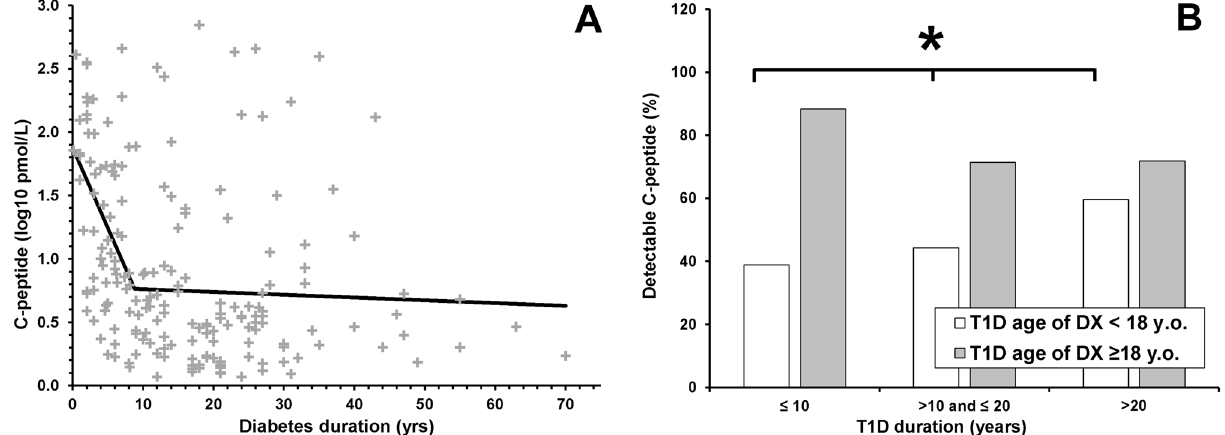
Figure 1. ( A ) Segmental linear regression of detectable C-peptide levels versus Type 1 diabetes duration. Overall r = 0.45, slope before threshold p = 0.0005, slope after threshold p = 0.66; diabetes duration threshold 8.8 (95% CI 5.7, 11.9) years ( p < 0.0001). ( B ) Comparison of proportion of detectable C-peptide in participants with diabetes stratified by age of diabetes diagnosis and duration. Significant positive trend in percentage of detectable C-peptide with diabetes duration in diabetes diagnosed below 18 y.o. ( p = 0.01) and borderline negative trend in diabetes diagnosed ≥ 18 y.o. ( p = Different detectable C‑peptide rates and levels by age of diabetes onset and duration. Plasma C-peptide was detectable in 46.3% (114 of 246) and 79.2% (76 of 96) of participants with diabetes aged < 18 y.o. and ≥ 18 y.o. at diabetes diagnosis respectively, p < 0.0001. In those with detectable C-peptide, the median C-peptide levels were lower in participants with diabetes with earlier (< 18 y.o.) versus later onset (≥ 18 y.o.) dia- betes: 4.2 (2.6–12.2) pmol/L versus 8.0 (2.3–80.5) pmol/L, p = 0.02. C-peptide was detectable in 53.8%, 50% and 62.2% participants with diabetes duration ≤ 10 years, 10–20 years and > 20 years respectively (trend p = 0.22). In people with childhood-onset diabetes C-peptide was more often detectable in those with longer versus shorter diabetes duration (60% vs. 39%, p for positive trend < 0.05). In those with diabetes diagnosed at age ≥ 18y.o there was a non-significant negative trend for the percentage of people with detectable C-peptide and diabetes dura- tion (from 88 to 72%, p = 0.07) (Fig. 1B). For those with detectable C-peptide, C-peptide levels did not differ significantly by diabetes duration. There was no difference in detectable C-peptide rates with diabetes duration in participants diagnosed below and above 13 years of age, a common age of diabetes onset and puberty 15 (ESM Fig. 1). There were no significant differences between C-peptide detectability or levels by diabetes complications status (data not shown). C‑peptide micro‑secretion is associated with lower HbA1c. There were no significant differences in concurrent HbA1c levels by diabetes duration if C-peptide status was not considered. However, participants with diabetes, with detectable versus undetectable C-peptide, had lower concurrent HbA1c levels: 8.2 ± 1.7% (66 ± 18 mmol/mol) versus 8.5 ± 1.4% (70 ± 16 mmol/mol), p = 0.001. In those with earlier diabetes onset (< 18 y.o.) HbA1c was lower with detectable versus undetectable C-peptide: 8.4 ± 1.8% (68 ± 19 mmol/mol) versus 8.6 ± 1.5% (70 ± 16 mmol/mol) respectively, p = 0.045. Similar results were observed in participants with adult- onset diabetes and detectable versus undetectable C-peptide: (7.7 ± 1.3% (61 ± 15 mmol/mol) versus 8.2 ± 1.1% (66 ± 12 mmol/mol) respectively, p = 0.053. Overall HbA1c levels were significantly lower in participants diagnosed at adult versus childhood age with- out considering C-peptide detectability status: 7.8 ± 1.3% (62 ± 14 mmol/mol) versus 8.5 ± 1.6% (69 ± 18 mmol/ mol), p = 0.001. HbA1c was lower in participants with detectable versus undetectable C-peptide in most diabetes duration categories, but reached statistical significance only in participants with 10–20 years diabetes: 7.9 ± 1.3% (64 ± 14 mmol/mol) versus 8.8 ± 1.4% (73 ± 16 mmol/mol), p = 0.003. Detectable C-peptide was not a significant predictor ( p = 0.06) of concurrent HbA1c reaching recommended targets (< 7% (53 mmol/mol) for adults, < 7.5% (58 mmol/mol) for youth) in models containing age, sex and age of T1D diagnosis (Table 2). Participants with detectable C-peptide had 97% (95%CI 23%, 217%; p = 0.005) higher odds of having a HbA1c level < 8% (64 mmol/mol) than those with non-detectable C-peptide in logistic regression (after adjustment for age, sex and age at diabetes onset) (Table 2). miRs profiles in participants with and without diabetes. The microRNA substudy included 305 participants with diabetes and 211 CON. Clinical characteristics are shown in Table 3. Expression of five miRs differed by diabetes status. miR-186 and miR-223 expression were significantly increased while miR-9, miR-22 and miR-125b were significantly decreased in people with diabetes versus CON (ESM Fig. 2 Panel A). Plasma miRs profiles by age of diabetes diagnosis and diabetes duration. Based on optimal cut- offs, determined with the classification tree using the CART algorithm for age of diabetes onset (DX) (17.5 y.o.) and diabetes duration (DUR) (16 years), participants were divided into four groups: